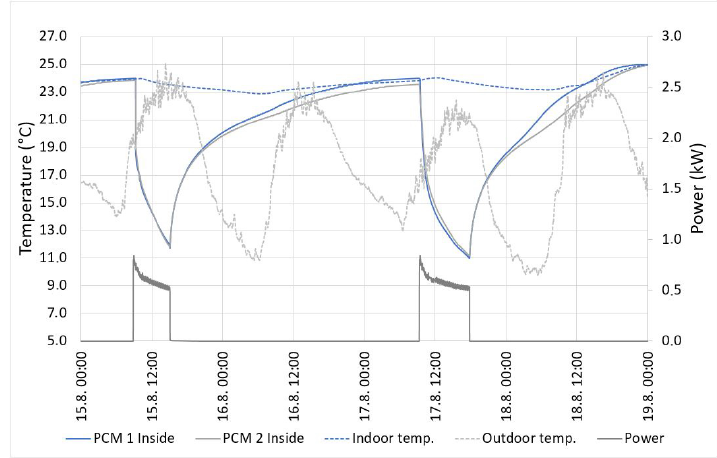
Figure 10. Active cooling—thermoelectric